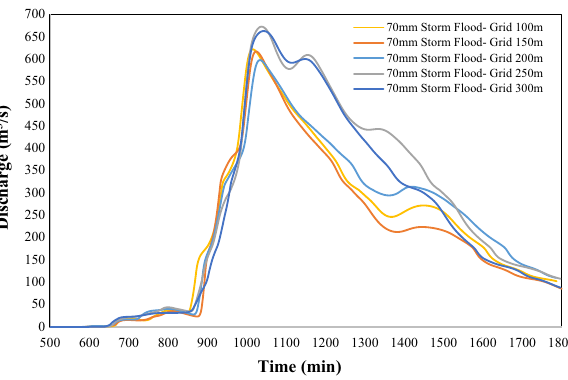
Fig. 21 Flood properties of calibrated GSSHA base model for a 24-h, 70 mm storm flood compared to hydrographs corresponding to GSSHA models with cell sizes of 100–300